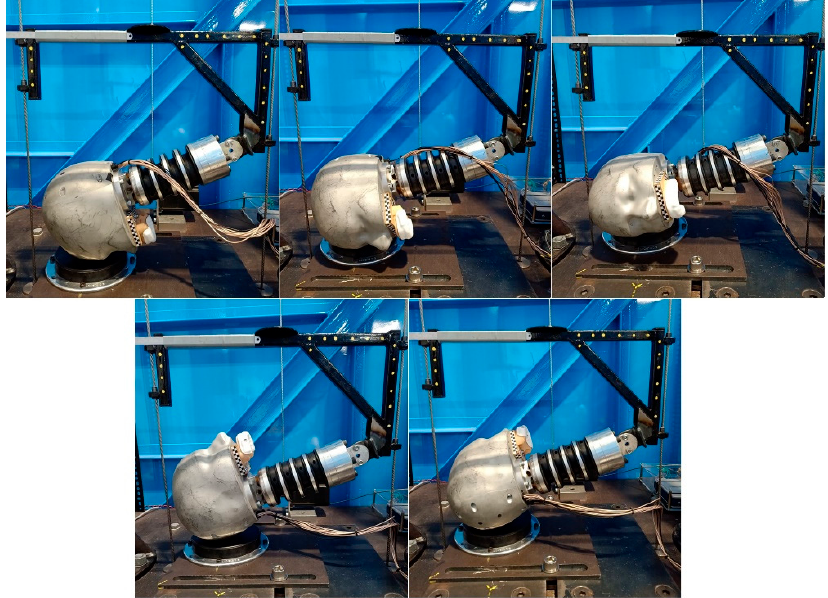
Figure 1. Impact locations, from top left to bottom right: front/forehead, front boss, side, rear, and rear boss. The mouthguard and dentition are both shown rigidly fixed to the upper jaw of the ATD headform.